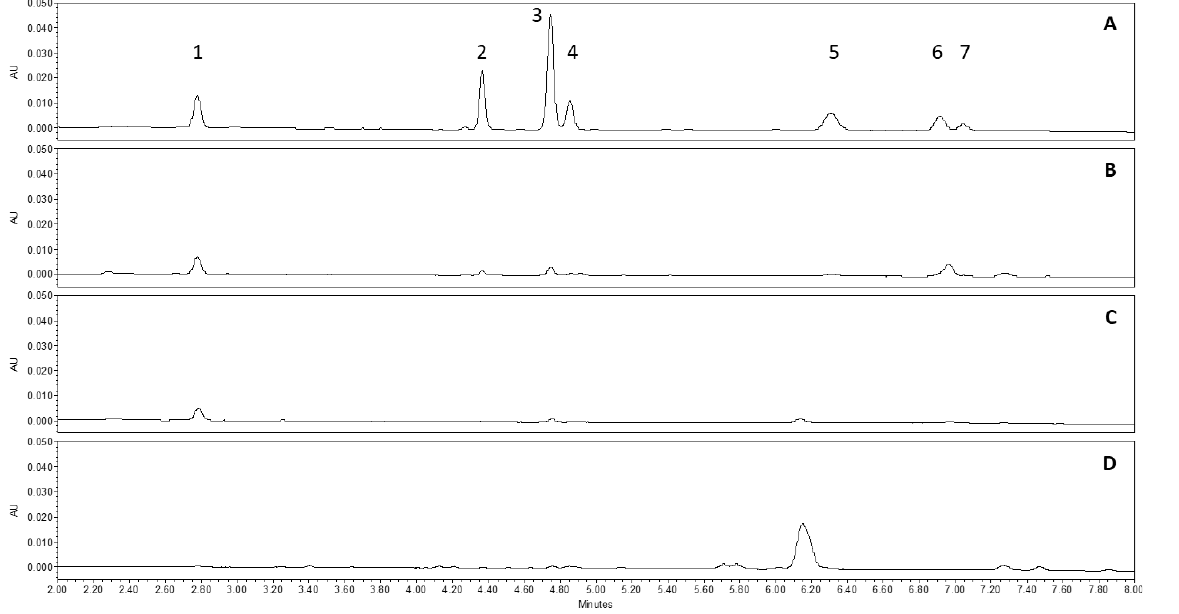
Figure 1. UHPLC-UV chromatograms (330 nm) of DCM sub-extracts (DSE) prepared at 100 μg.mL − 1 in MeOH for ( A ) cones, and 1 mg.mL − 1 in MeOH for ( B ) leaves, ( C ) stems and ( D ) rhizomes. Identified compounds and their retention time (rt) are: xanthohumol (1) rt 2.78 min, co-humulone (2) rt 4.37 min, humulone (3) rt 4.75 min, ad-humulone (4) rt 4.86 min, co-lupulone (5) rt 6.31 min, lupulone (6) rt 6.92 min, ad-lupulone (7) rt 7.05